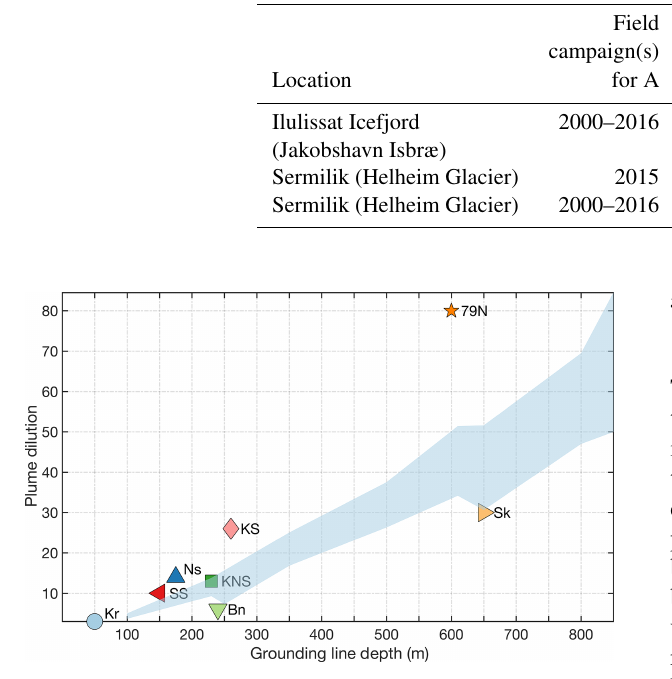
Figure 5. The plume dilution (entrainment) factor relationship with glacier grounding line depth as modelled by Carroll et al. (2016) for subglacial freshwater discharge rates of 250–500m 3 s − 1 and grounding lines of > 100m (shaded area). Also shown are the entrainment factors determined from field observations for Kro- nebreen (Kongsfjorden, Kr, Halbach et al., 2019), Bowdoin (Bn, Kanna et al., 2018), Saqqarliup Sermia (SS, Mankoff et al., 2016), Narsap Sermia (Ns, Meire et al., 2016a), Kangerlussuup Sermia (KS, Jackson et al., 2017), Kangiata Nunaata Sermia (KNS, Bendt- sen et al., 2015), Sermilik (Sk, Beaird et al., 2018) and Nioghalvf- jerdsfjorden Glacier (the “79 ◦ N Glacier”, 79N, Schaffer et al., 2020). Note that the 79 ◦ N Glacier is unusual compared to the other Arctic systems displayed as subglacial discharge there enters a large cavity beneath a floating ice tongue and accounts for only 11% of meltwater entering this cavity, with the rest derived from basal ice melt (Schaffer et al.,